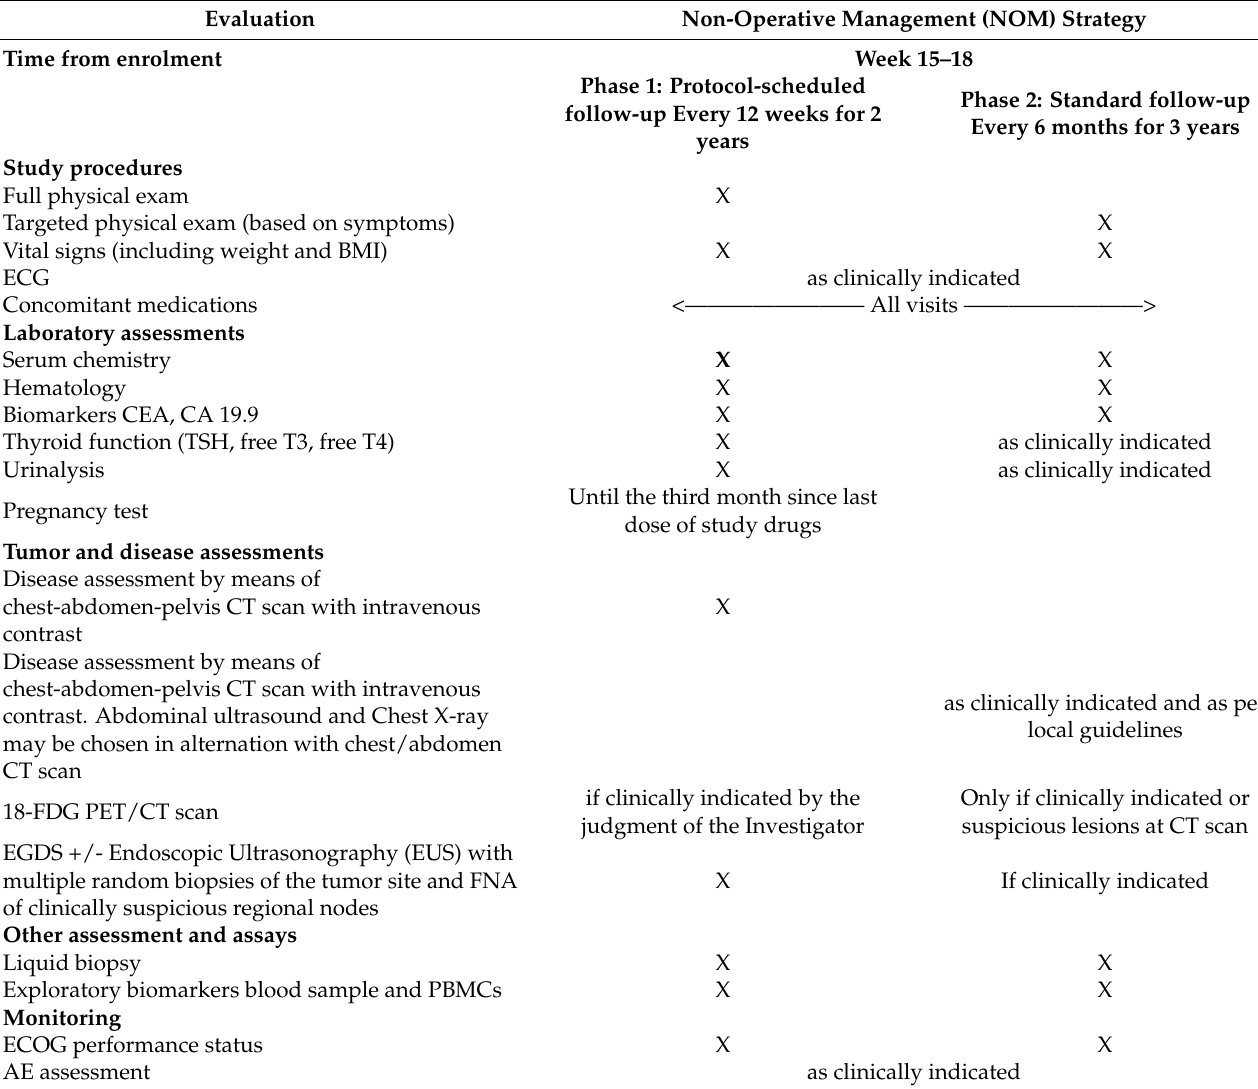
Table 3. Schedule of assessments for Cohort 2 patients with clinical complete